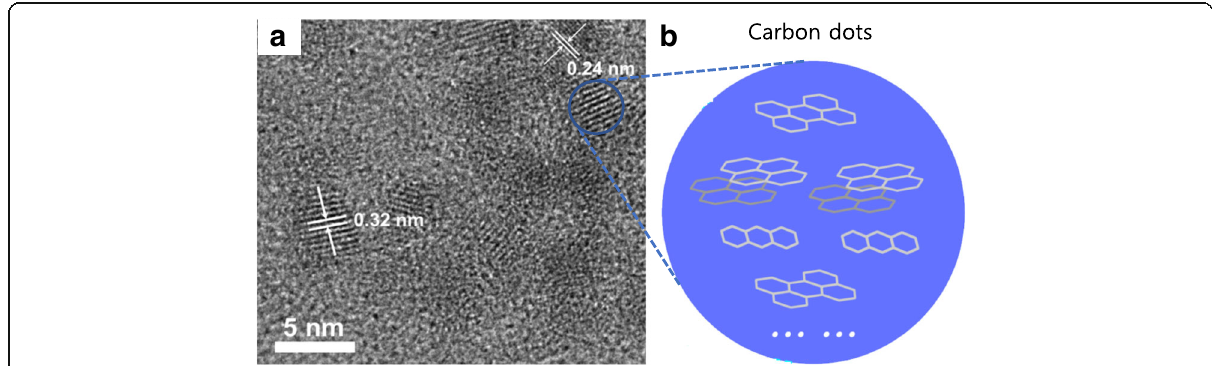
Fig. 4 a High-resolution TEM images showing measurement of the space between lattices of CDs and b schematic representation of CDs with a carbogenic core containing sp 2 carbon